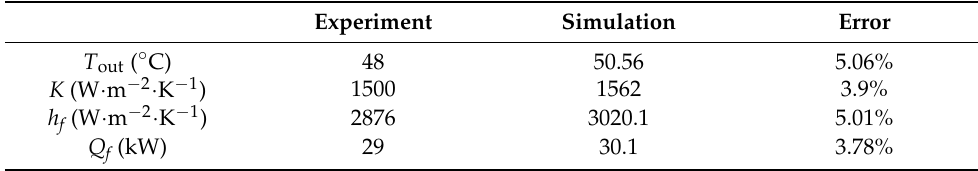
Table 6. Comparison of experimental and simulation results. Experiment